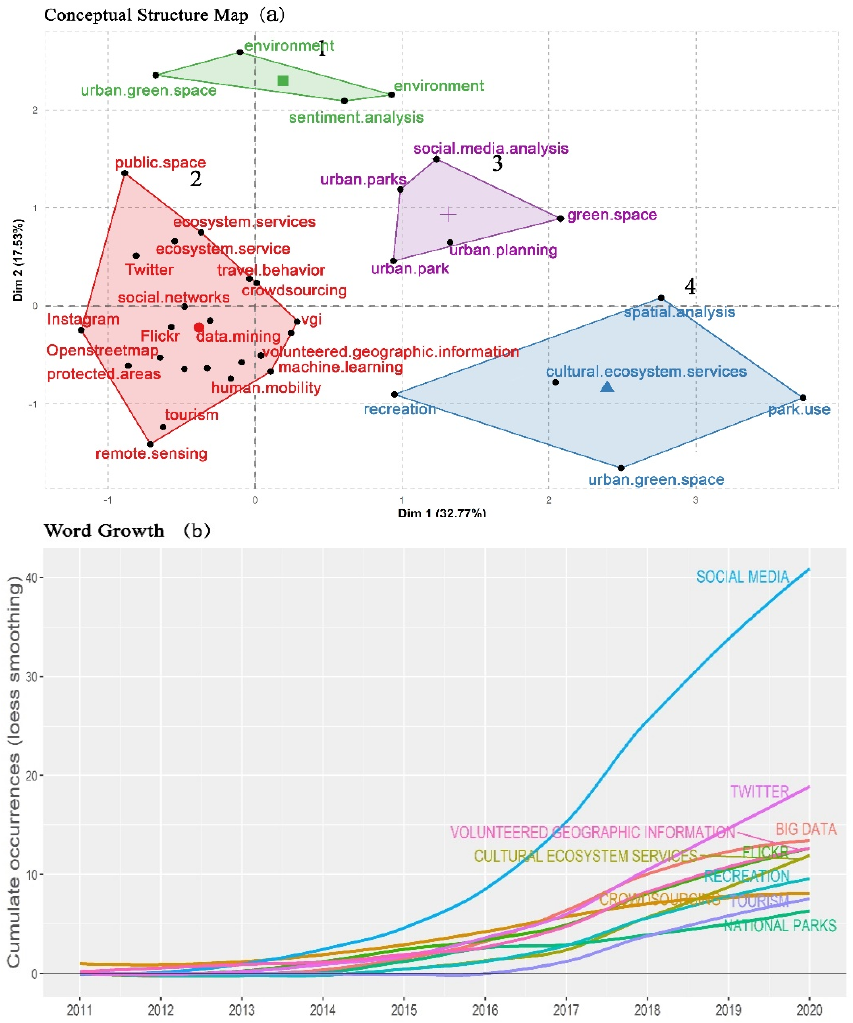
Figure 3. ( a ) Conceptual structure map and ( b ) cumulative occurrence of the keywords in the UGS and social media